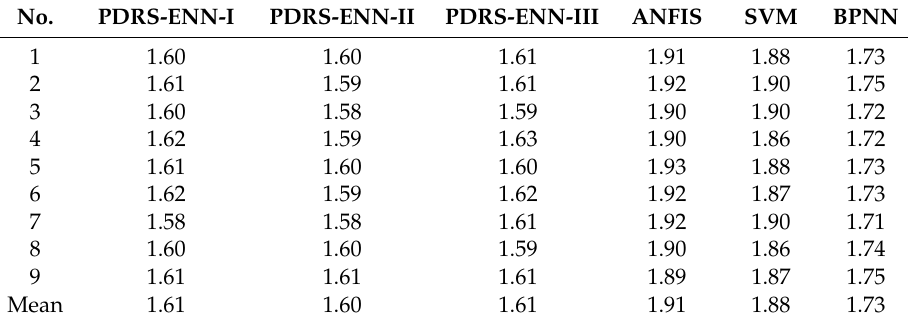
Table 11. The fitting performance evaluated by FVD of